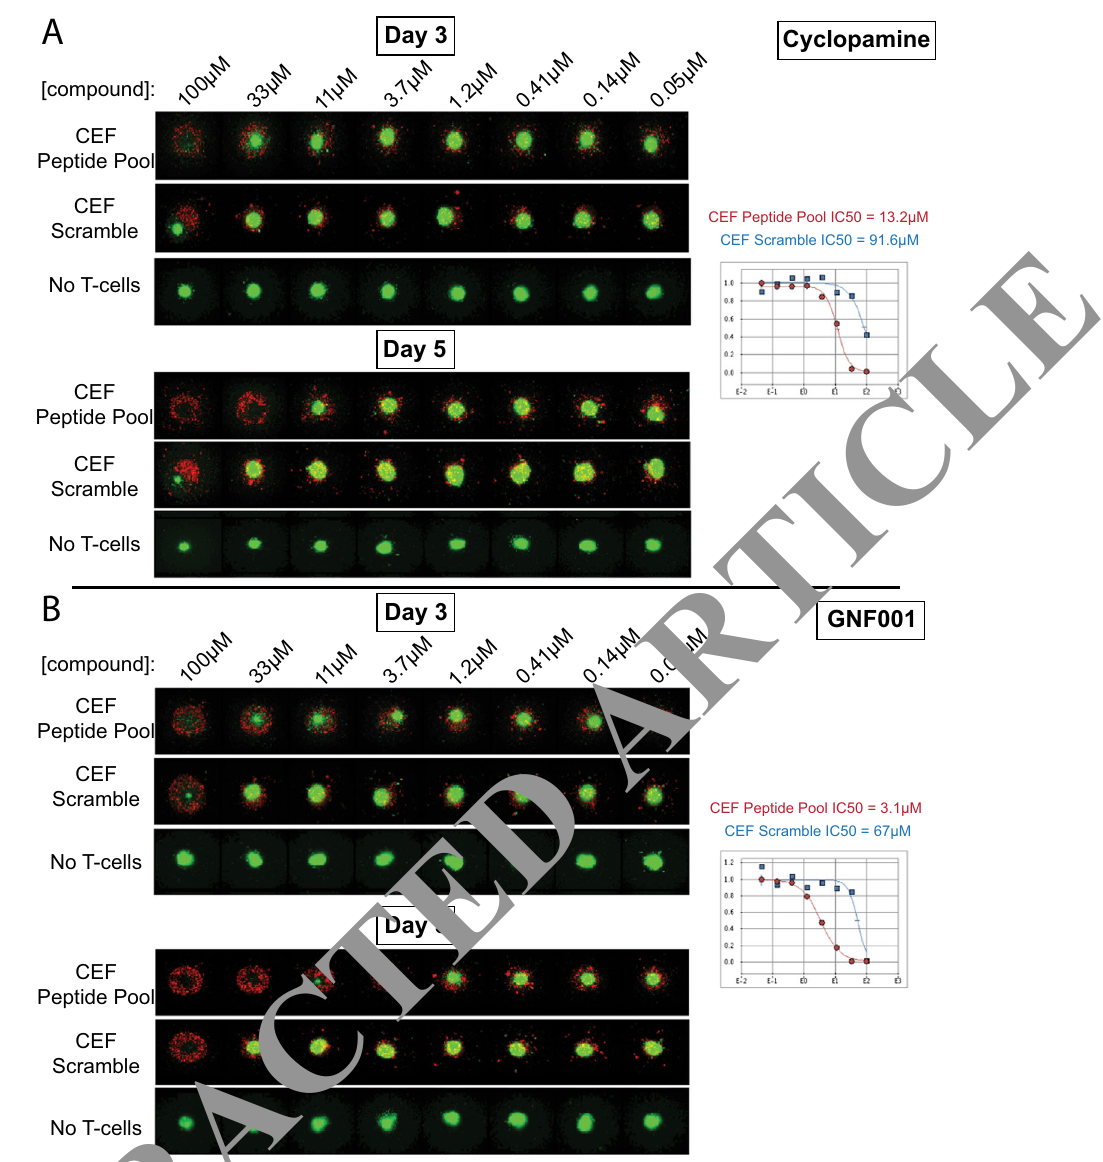
Fig. 6 Anti-tumor ef fi cacies of two lead compounds are time- and dose-dependent. a Dose response pro fi le of Cyclopamine, an inhibitor of SHH and Smoothened antagonist, at two-time points. Day 5 images and IC 50 curves reveal antigen-dependent anti-tumor T-cell behavior, where CEF Scramble or no T-cell control samples did not elicit signi fi cant phenotypes. b Dose – response pro fi le of GNF001, an inhibitor of an unknown protein target, at two-time points. Day 5 images and IC 50 curves reveal a 22-fold increase in compound potency when T-cells and tumor cells were primed with identical antigens (CEF Peptide Pool) compared to mismatched viral antigens (CEF